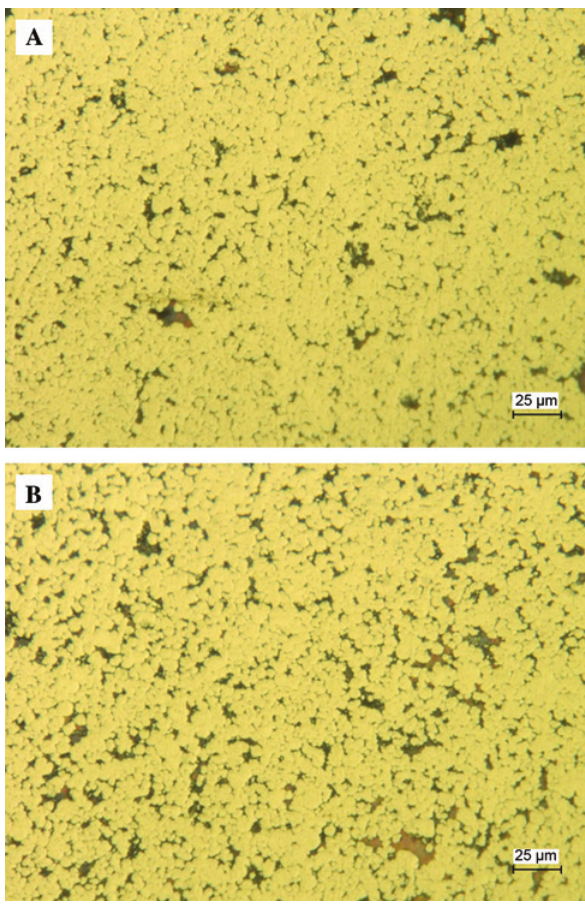
Figure 2: Sketch of the clamp used in the brazing